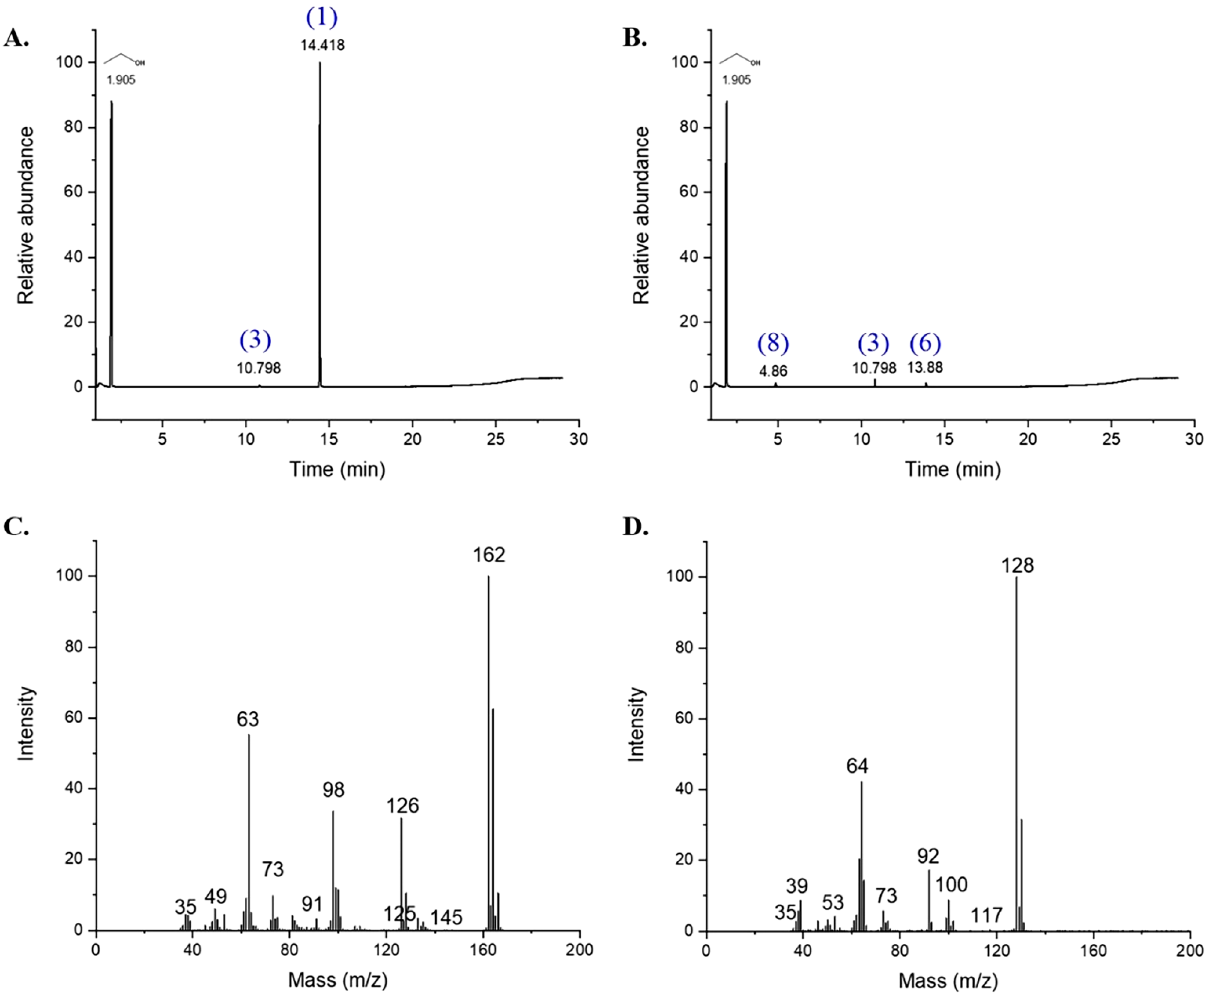
Figure 5. GC–MS analysis ( A ) Gas chromatography of 2,6-DCP the authentic sample (control), ( B ) Gas chromatography of the extracted bio-treated sample obtained during 2,6-DCP biodegradation by Trichoderma longibraciatum treated medium amended on the 12th day, ( C ) and ( D ) corresponding mass spectrum of the peak appearing at the chromatogram ( A ) and ( B ),